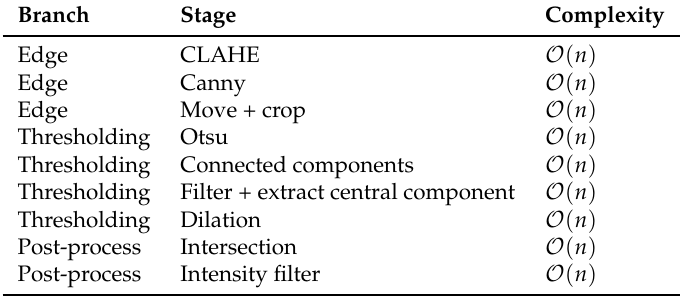
Table 1. Computational complexities of the seed generation pipeline as a function of n , the number of pixels in the input image. CLAHE, contrast-limited adaptive histogram